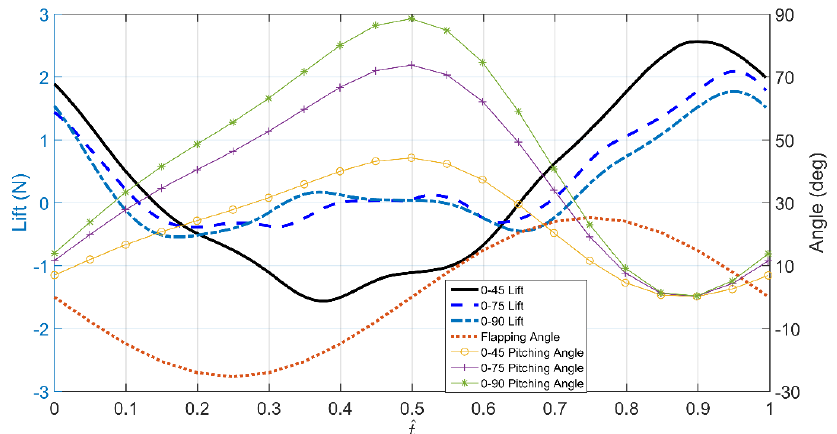
Figure 18. The lift forces of flapping wing with pitching angle case 0°~45°, 0°~75° and 0°~90° (down-stroke: 𝑡̂ = 0~0.25; up-stroke: 𝑡̂ = 0.25~0.75; down-stroke: 𝑡̂ = 0.75~1).